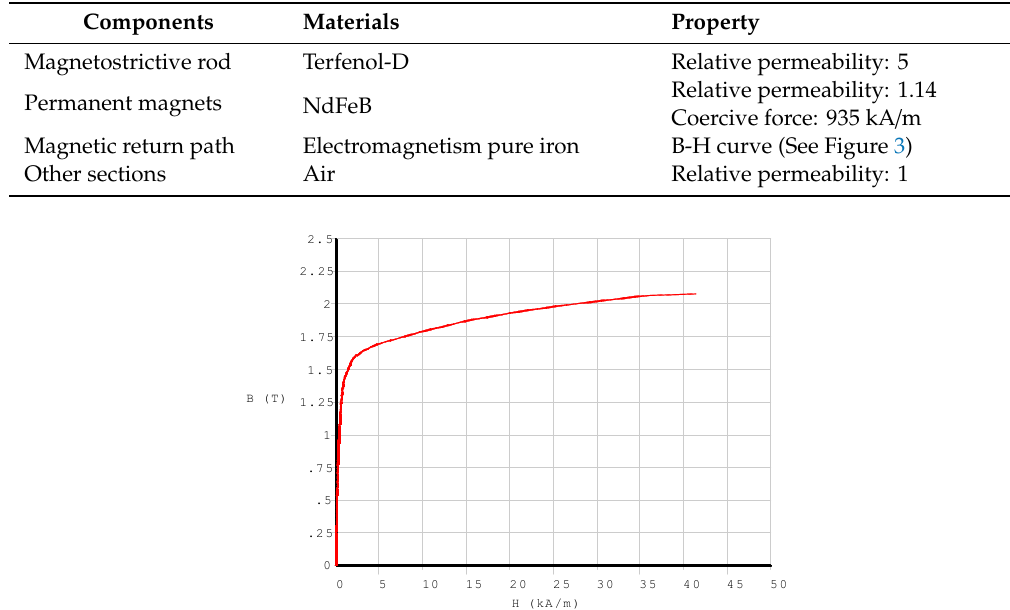
Table 2. Material properties of the components in the magnet circuit.